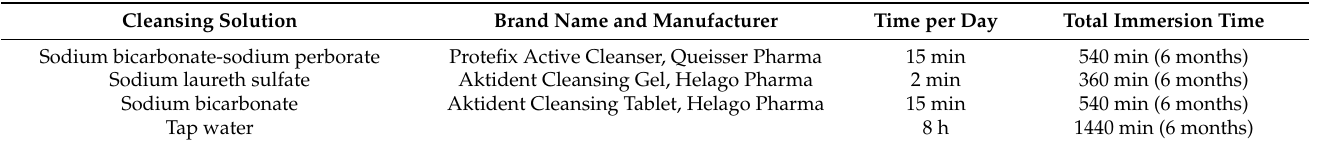
Table 2. Tested denture cleansing solutions and cleaning schedule.